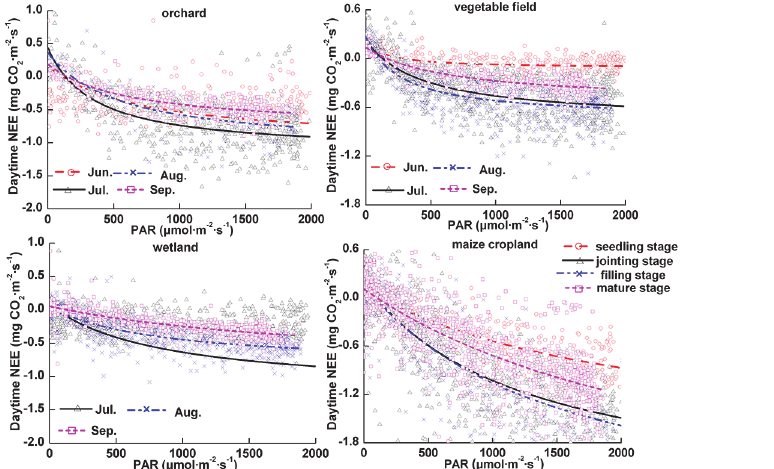
Fig 4. Response of NEE to PAR in different